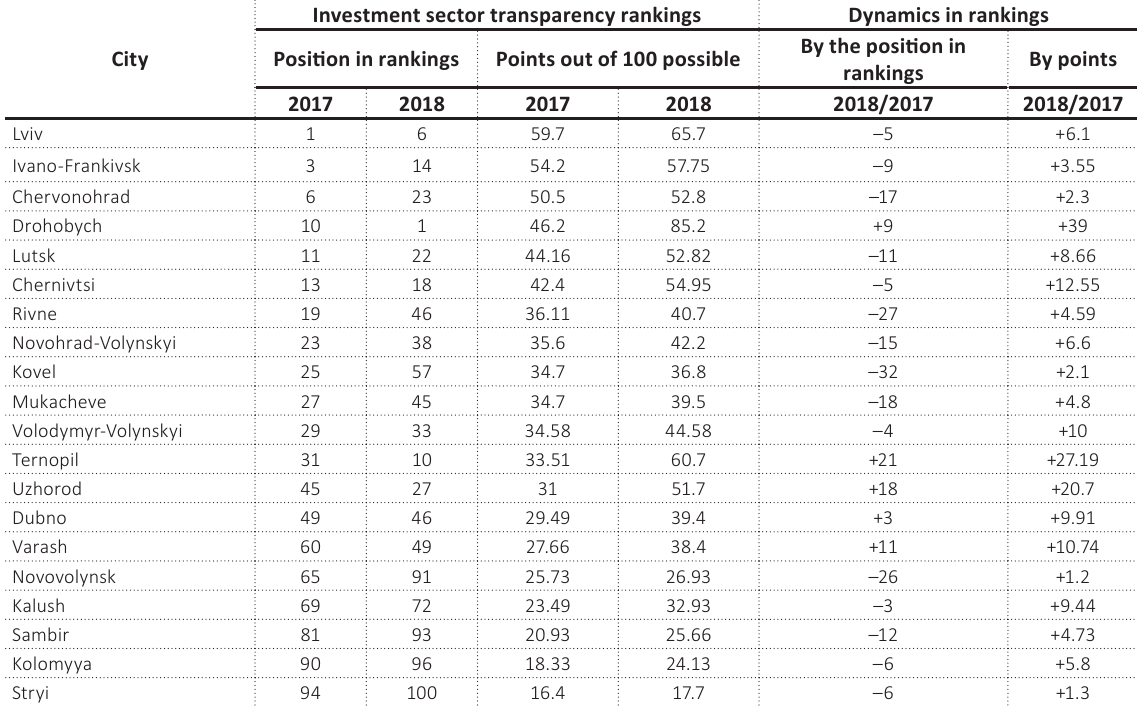
Table 2. Cities of the Western region in investment sector transparency rankings for the 100 largest cities of